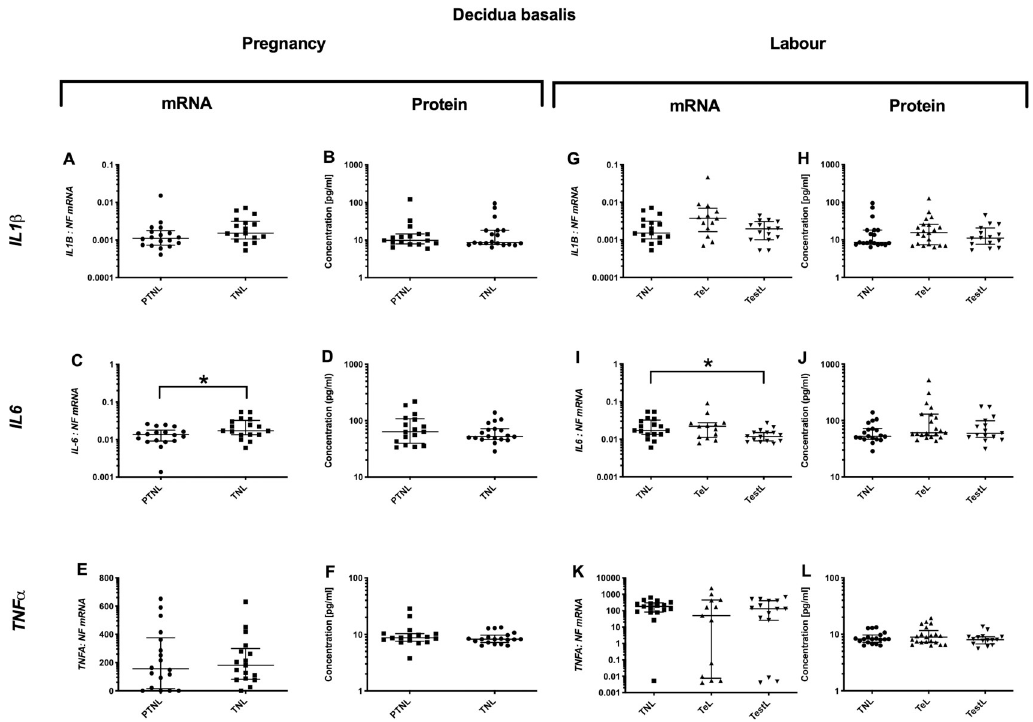
Fig 4. Pro-inflammatory cytokine changes in the decidua basalis. Cytokine levels in the decidual basalis tissues from four groups of women (mean gestational age ± SD in each case), PTNL (33.8 ± 1.7weeks, n = 17), TNL (39.3 ± 0.8 weeks, n = 19), TeL (38.4 ± 1.3weeks, n = 21) and TestL (39.5 ± 1.0, n = 15). Tissue levels of the cytokines were quantified using Bio-plex human cytokine 19-plex-array kit (Bio-rad) as describe in Materials and Methods . A subset of amnion samples, PTNL (33.8 ± 1.7 weeks, n = 17), TNL (39.3 ± 0.9 weeks, n = 16), TeL (38.6 ± 1.2 weeks, n = 13) and TestL (39.5 ± 1.0, n = 15) were used to compare the mRNA expression using rtPCR of IL-1 β , IL6 and TNF α mRNA. Normally distributed data were analysed using a Student’s t-test for two groups and an ANOVA followed by a Dunnett’s or Bonferroni’s post-hoc test for three groups or more. Data that were not normally distributed were analysed using a Mann Whitney test for 2 groups and when comparing three groups or more a Friedman’s test, with a Dunn’s multiple comparisons post-hoc test. The data are shown as median with interquartile range. The p values are demonstrated by � is p < 0.05 and �� is p <